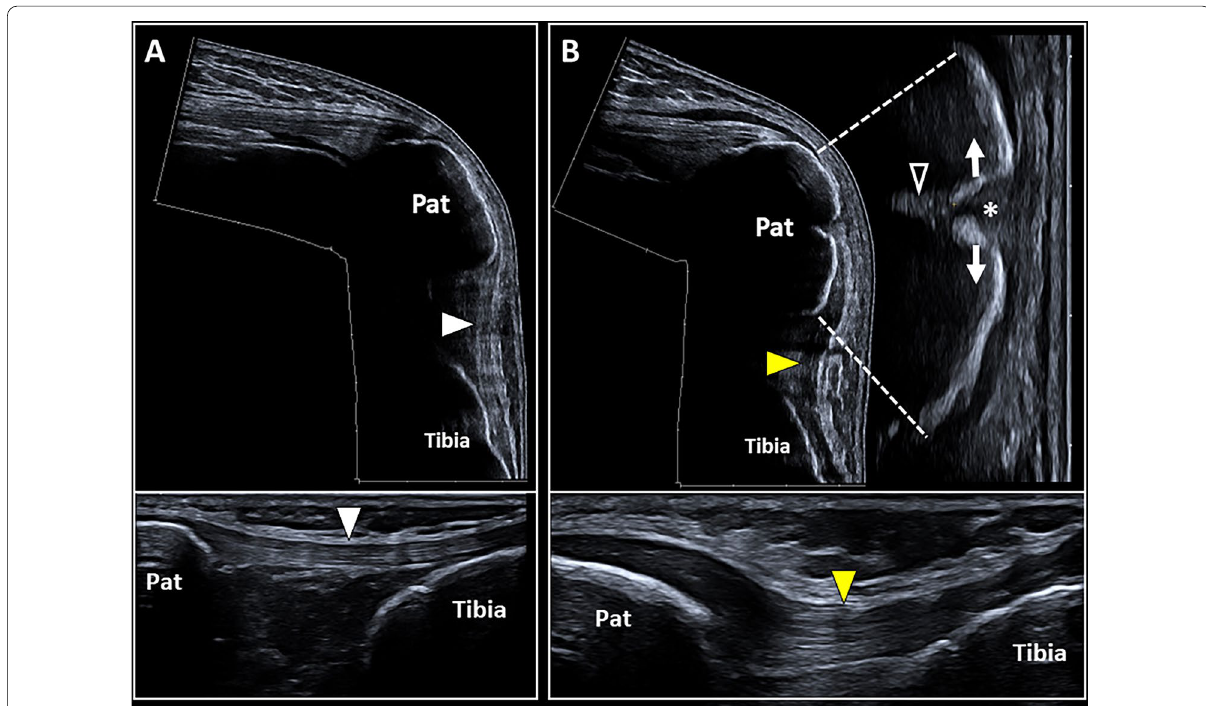
Fig. 3 Pathological sonographic findings of the bone tissue. The comparative sonographic assessment shows a continued hyperechoic cortical bone of the patella ( Pat ) with a tensioned patellar ligament ( white arrowhead ) on the healthy side ( A ); instead, cortical defect ( white asterisk ) of the patella ( Pat ), diastasis of bony fragments ( white arrows ), and deformation of the patellar ligament ( yellow arrowhead ) are clearly visible in the post-traumatic knee ( B ). Of note, the disruption of the bony cortex allows the US beam to partially penetrate within the bone tissue generating an echoic wedge ( void arrowhead ) ( B